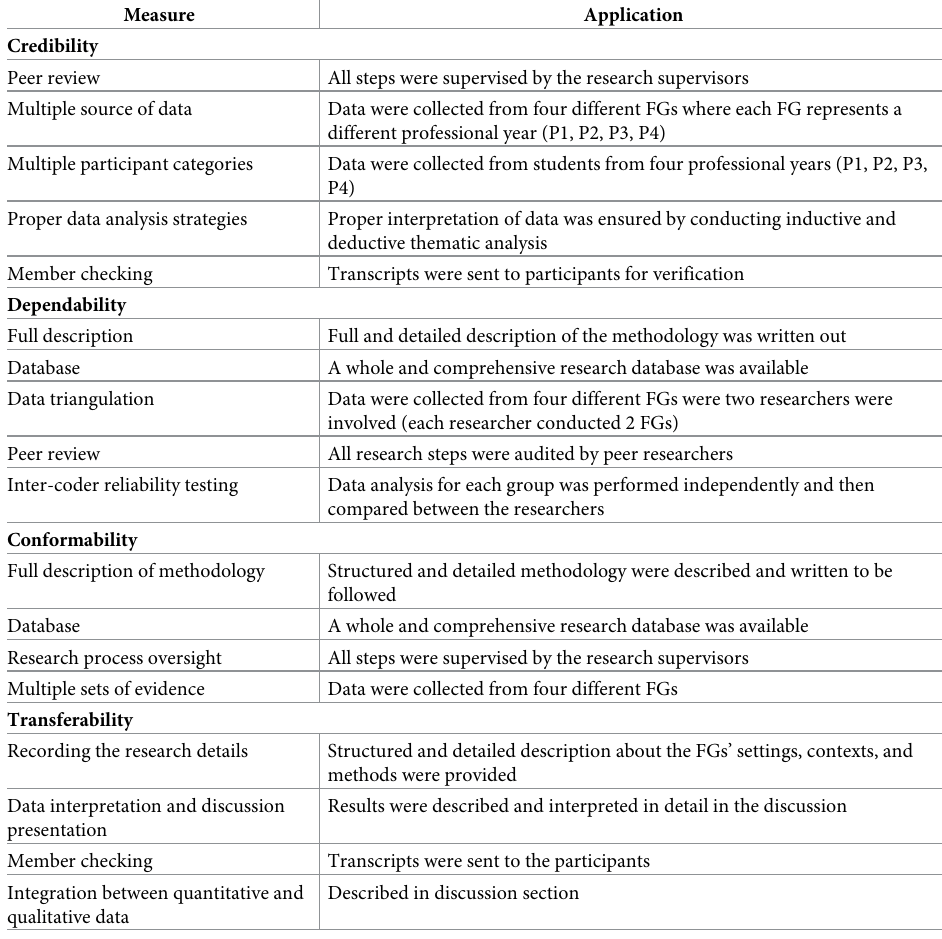
Table 3. Qualitative quality